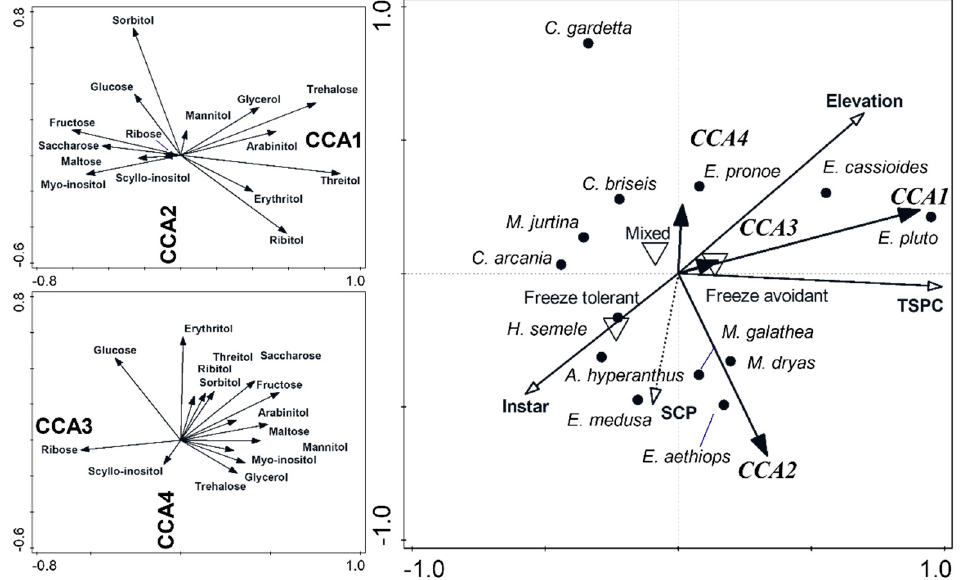
Figure 5. Relating cold hardiness and overwintering-related traits to sugars and polyol profiles of overwintering larvae of European monovoltine Satyrinae. The two left panels show CCA ordination species ≈ compounds|treatment (eigenvalues 0.906, 0.832, 0.792, 0.692; adjusted explained variation 40.6%, F/P 1st axis = 18.9/0.001, F/P all axes = 12.2/0.001). The panel in the right is a triplot, showing the relation of the CCA axes (thick black darts) from the left panel to the traits. Traits significantly related to the axes are shown as narrow full darts; those without significant contribution (depicted as supplementary variables) as dotted darts or white triangles. The right panel model eigenvalues: 0.239, 0.148, 0.092, 0.250; explained variation 30.5%; F/P 1st axis = 2.8/ < 0.01, F/P all axes = 2.8/ < 0.01.